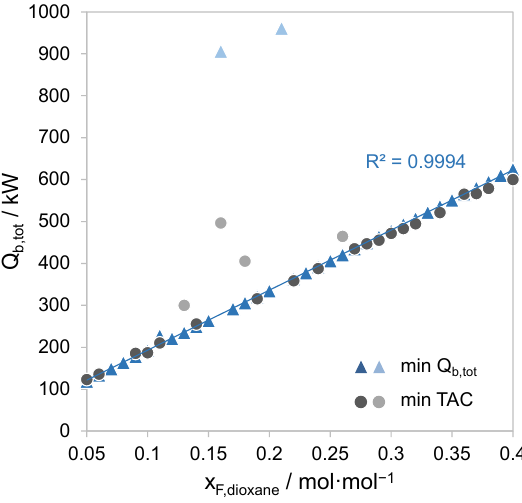
Figure A3. Set of solutions for the heteroazeotropic distillation of 1,4-dioxane and water using benzene as solvent. The blue triangles represent intermediate results during the polylithic solution strategy without cost and sizing equations, considering the total reboiler duty as the objective function. The circles mark the final results after the structural optimization w.r.t. the total annualized costs (TAC). The light-gray circles correspond to the outliers in Figure